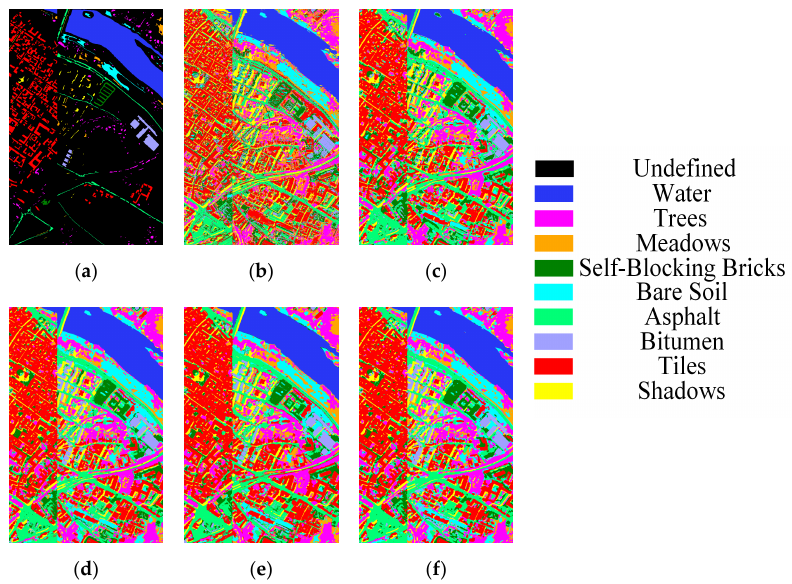
Figure 12. Classification maps for Pavia Center dataset: ( a ) Ground-truth map, ( b ) SSLSTMs, OA = 97.16%, ( c ) 3D CNN, OA = 98.33%, ( d ) FDSSC, OA = 99.83%, ( e ) SSRN, OA = 99.76%, ( f ) SSCC, OA = 99.84%.